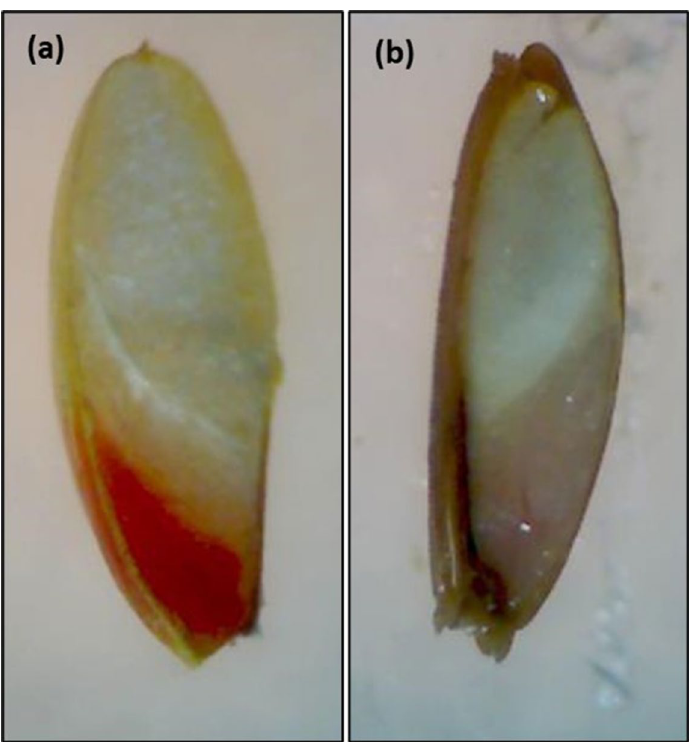
Figure 3. Urochloa grass seeds stained with 0.1% tetrazolium solution, ( a ) viable seed showing red embryo, and ( b ) dead seed showing brown